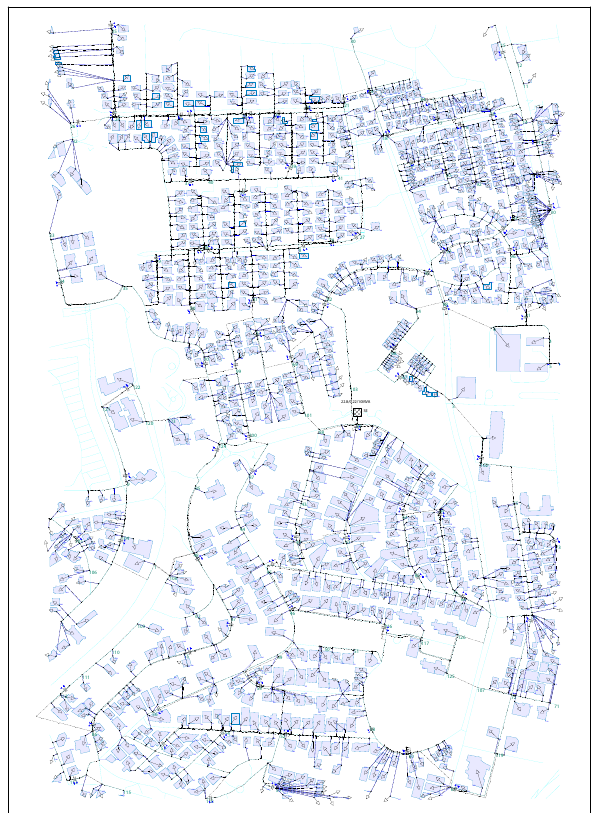
Figure 10. Distribution network deployment in